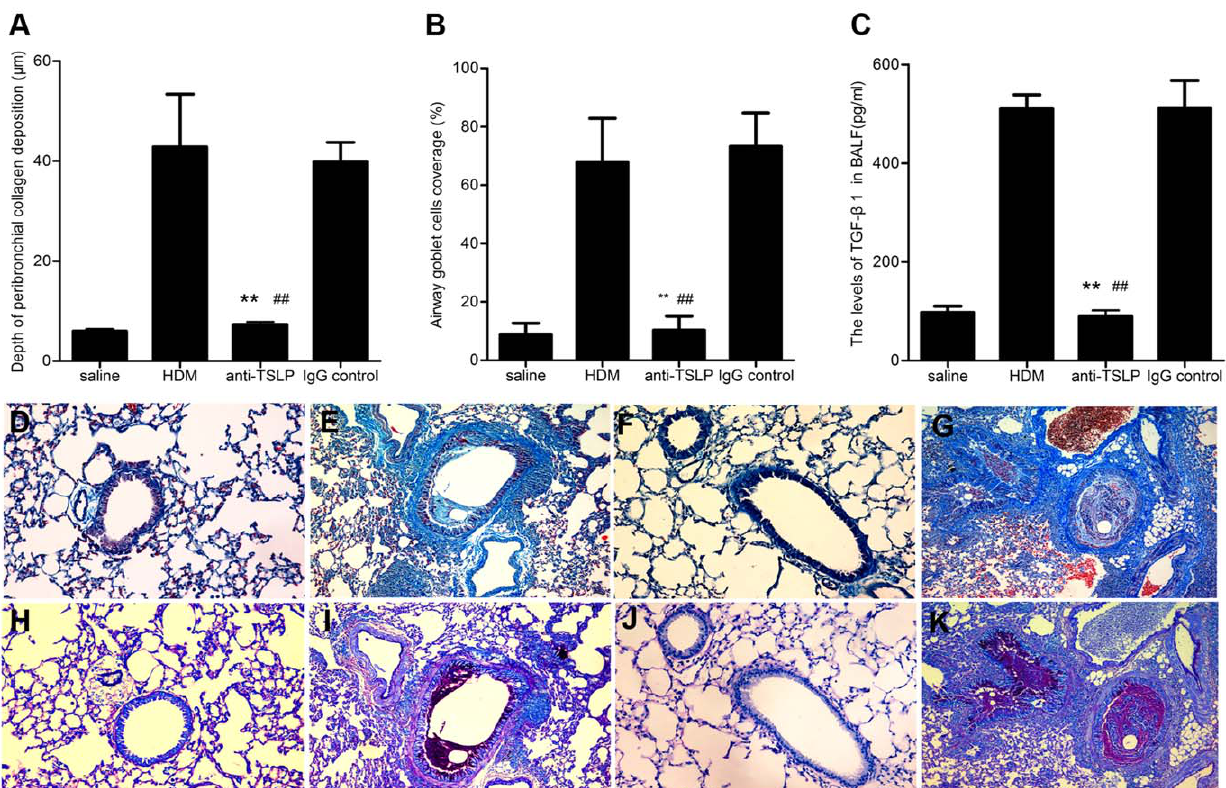
Figure 4. TSLP neutralization inhibits airway structural alterations. (A) The depth of peribronchial collagen deposition was significantly reduced in anti-TSLP-treated mice, compared with HDM-exposed and IgG isotype-treated controls. (B) Epithelial goblet cells were markedly reduced in anti-TSLP-treated mice, compared to the HDM-exposed and IgG -treated controls. (C) TGF- b 1 levels in the BALF were significantly increased in HDM-exposed mice. The blockage of TSLP with the anti-TSLP mAb reduced TGF- b 1levels in the BALF. TGF- b 1 protein and mRNA levels were determined in duplicate experiments. (D-G) Representative photomicrographs of Masson’s trichrome-stained lung sections from mice that were exposed for 5 weeks to saline (D) or HDM (E) and pretreated with anti-TSLP mAb (F) or an IgG-treated control (G) 60 minutes prior to and during HDM exposure. (H-K) Representative photomicrographs of airway sections of PAS-stained from mice that were exposed for 5 weeks to saline (H) or HDM (I) and pretreated with anti-TSLP mAb (J) or an IgG-treated control (K) 60 minutes prior to and during the HDM exposure. Original magnification, 20 6 . The data shown represent the means 6 SEM (n=5), **p , 0.01 compared with the HDM group, ## p , 0.01 compared with the IgG-treated control mice. The photomicrographs of H-K are representative of 5 independent